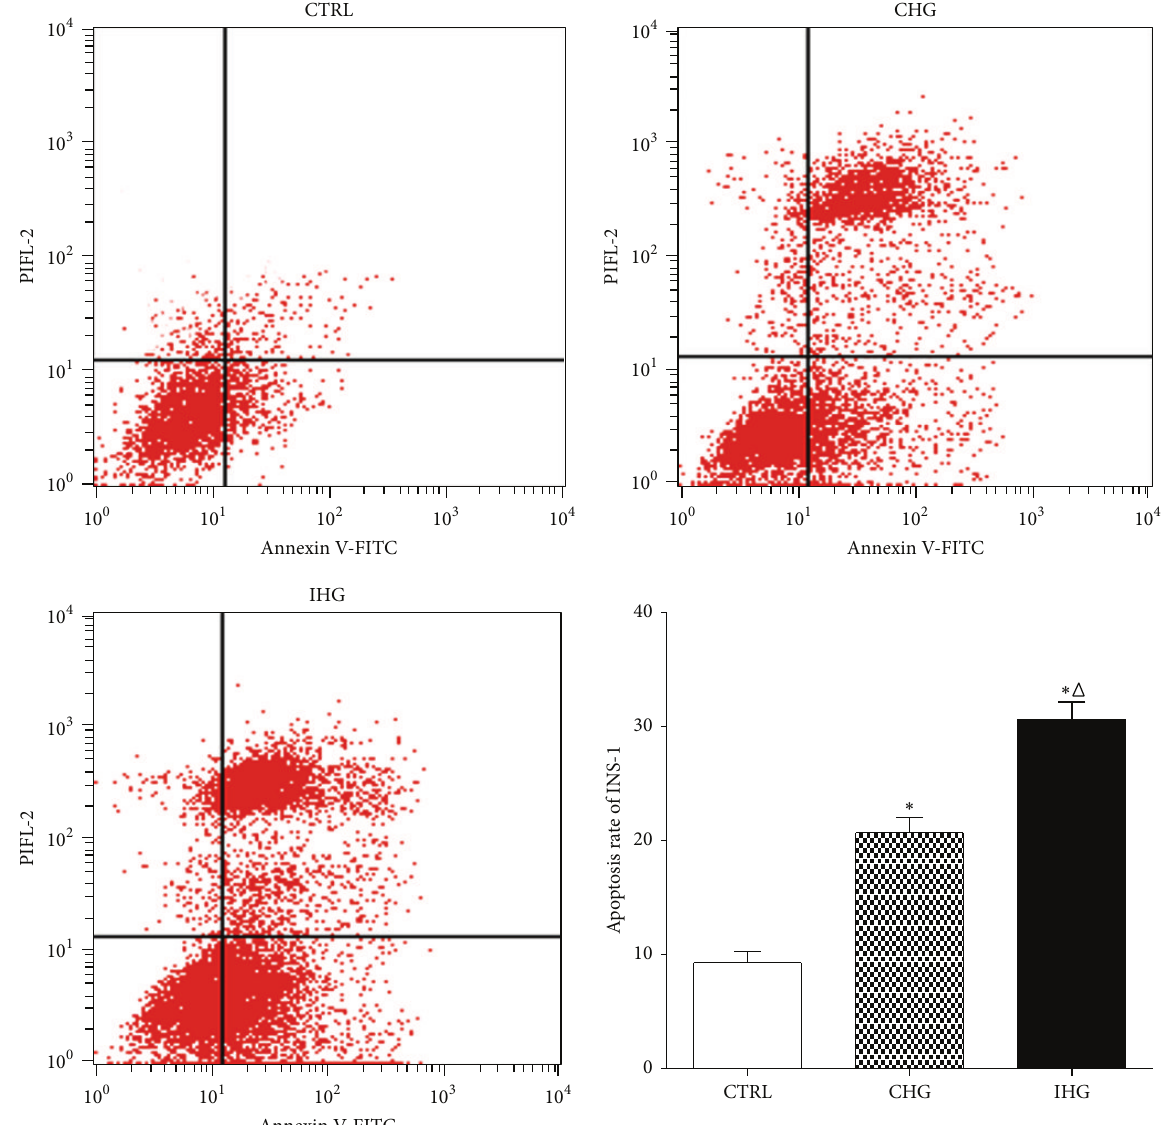
Figure 1: Determination of apoptotic cells with flow cytometry. After the treatment for 7 days, cells were collected for the detection of cell apoptosisasdescribedpreviously.Thepercentageofapoptoticcellswasshownafteranalysisbyflowcytometry.Datawereexpressedasmean ± SD of three determinations. Control, normal glucose; CHG, constant high glucose; IHG, intermittent high glucose. ∗ 𝑃 < 0.05 , and Δ 𝑃 < 0.05 respectively, indicate a significant difference from controls and